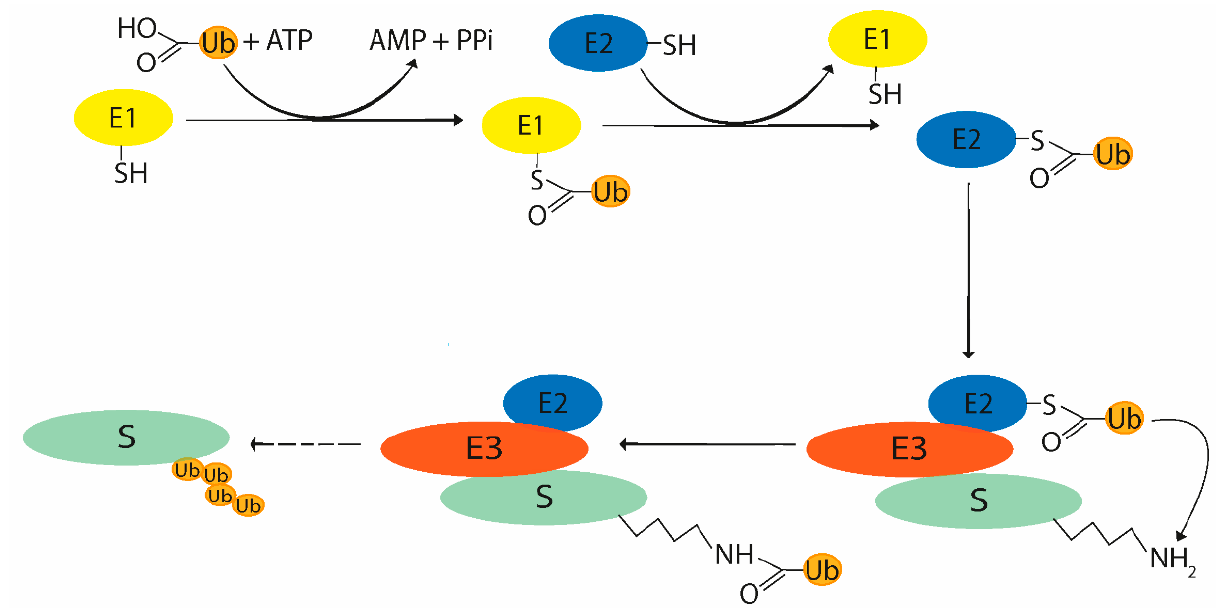
Figure 2. Scheme of ubiquitin binding to the target protein [22]. Ub is activated by ATP-assisted acyl-adenylation, bound to the Ub-activating enzyme (E1), transferred to Ub-conjugating enzyme (E2), and attached to the target protein substrate (S) through Ub-ligase (E3). This cycle mechanism can be repeated for the creation of a polyubiquitin chain. ATP—adenosine triphosphate, AMP—adenosine monophosphate, PPi—pyrophosphate, Ub—ubiquitin. Adapted from [22].